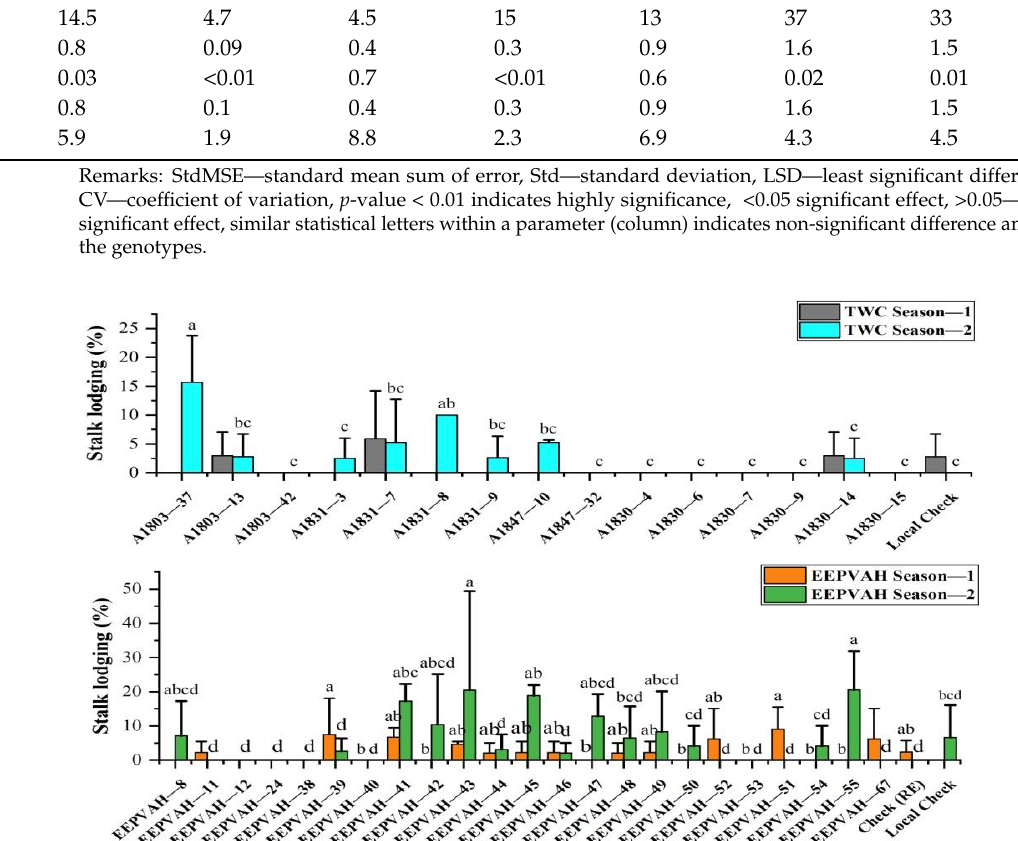
Figure 3. Stalk lodging recorded from maize genotypes of EEPVAH and TWC trials conducted in two contrasting seasons. Similar statistical letters for a season indicates non-significant effect, genotypes having only statistical letters and without a visible bar indicates no report of stalk lodging (zero lodging). Error bar reports only the positive values.